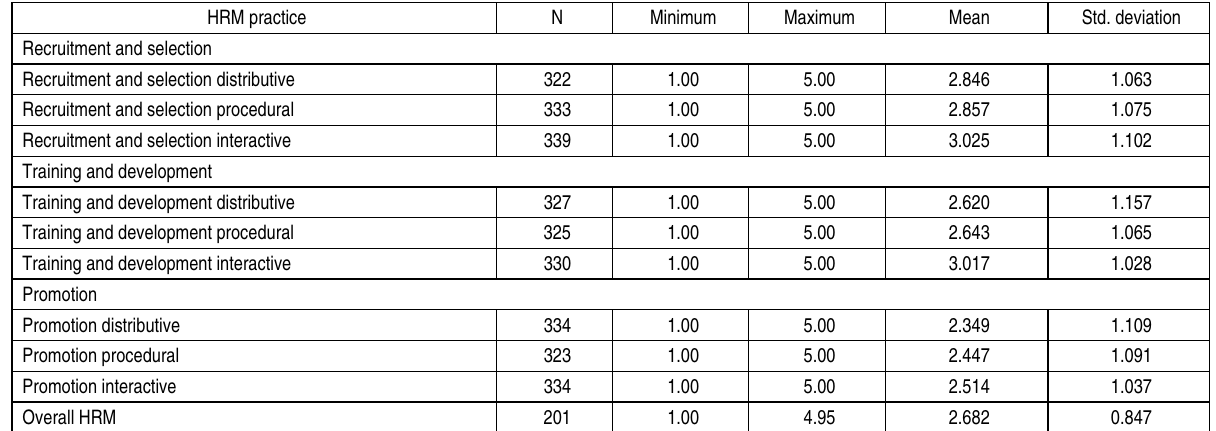
Table 1 (cont.). Summary statistics for HRM practices